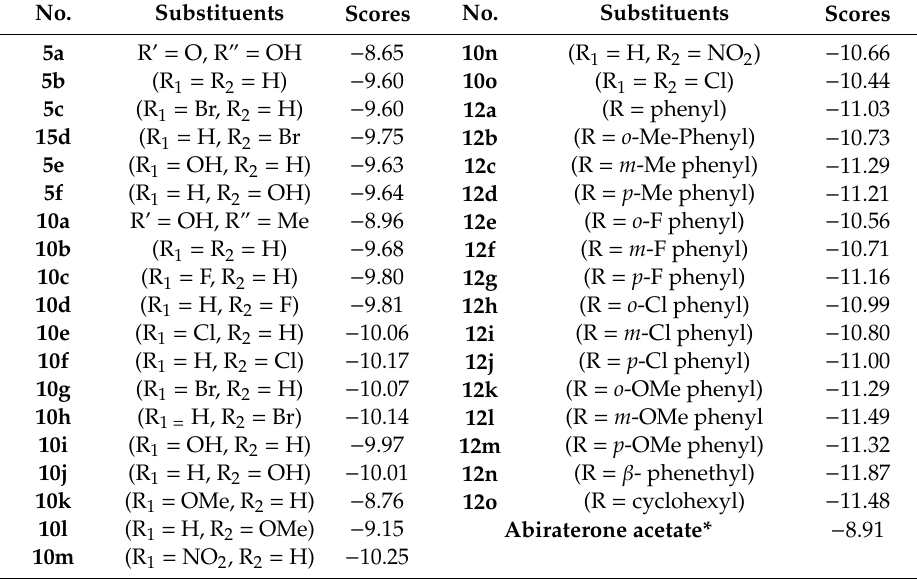
Table 7. Binding a ffi nity scores of the compounds 5a − f, 10a − o , and 12a − o with